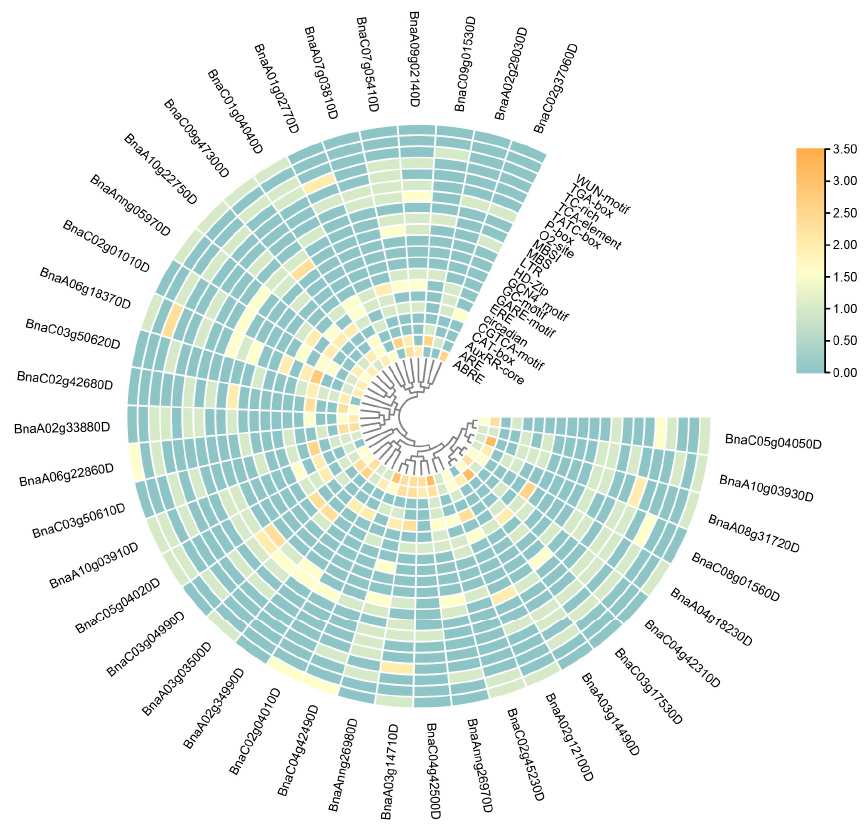
Figure 4. Cis-acting regulatory elements identified in ARI gene promoters in B. napus . The color bar shows log2 of copy number of cis-elements from low (cadetblue) to high (orange). Stress-related elements were predominant in ARIs promoters and these included ARE (an element that responds to anaerobic induction), LTR (an element responsive to low temperature), MBS (the MYB binding site for drought stress), WUN-motif (an element responsive to wounds), TC-rich (a defense-responsive element), and GC-motif (an anoxic-